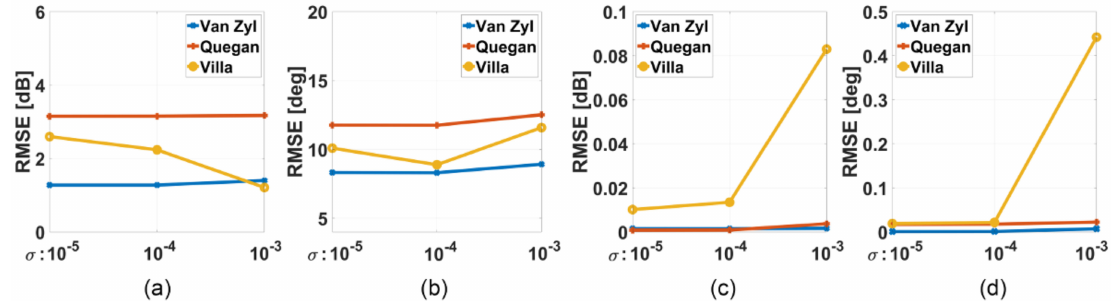
Figure 12. The Effect of the amount of non-zero co- and cross-polarization correlation terms on the RMSE of ( a ) crosstalk amplitude, ( b ) crosstalk phase, ( c ) imbalances amplitude, and ( d ) imbalance phase